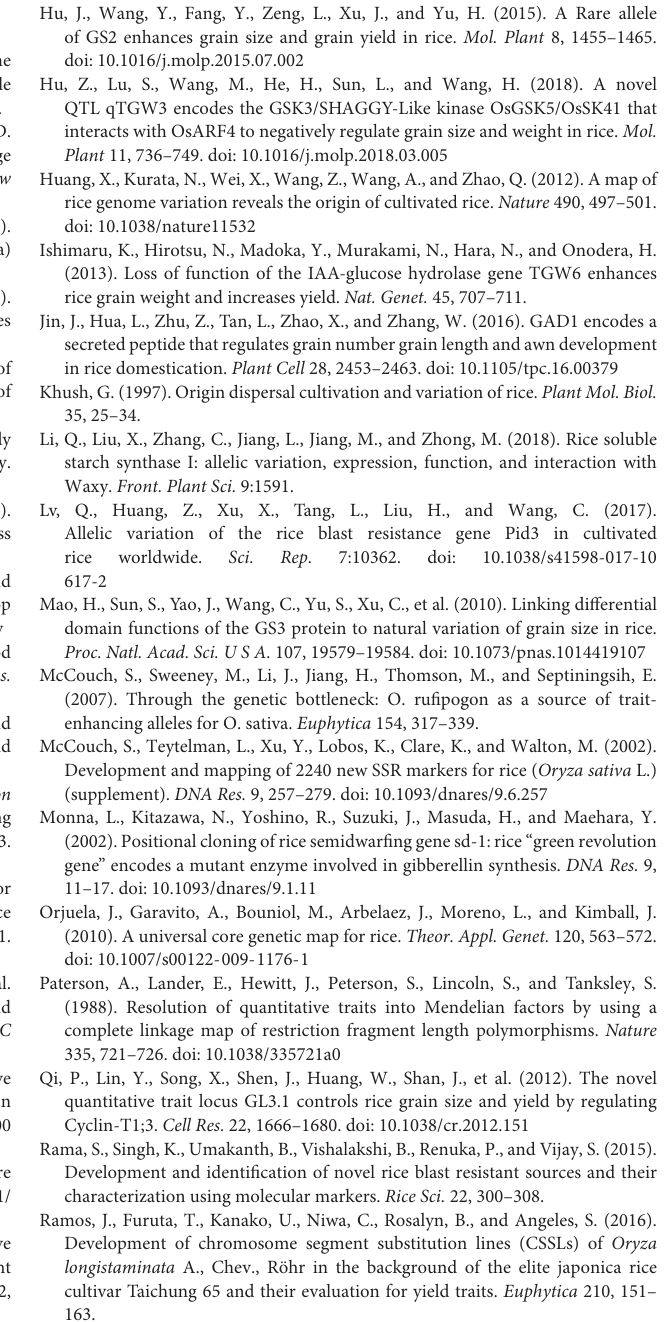
Supplementary Figure 8 | Chromosome segments distribution and coverage degree of introgression library from the donor of upland rice. Each block at the row represented introgression from a total of 731 ILs on the target chromosome, regardless of introgression segments in other chromosomes, and each column represented a molecular marker